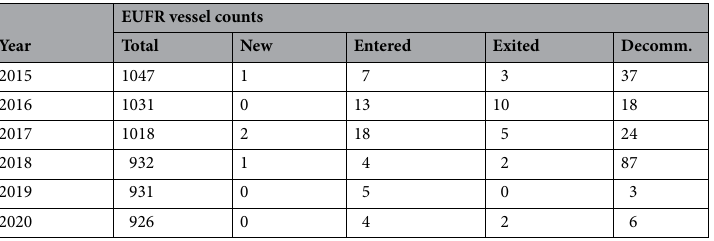
Table 2. Annual statistics of EU vessels registered to Adriatic ports according to the EU Fleet Register (EUFR): Total number of registered vessels; Newly constructed vessels; Vessels that moved their registration to an Adriatic port; Vessels that moved their registration outside the Adriatic; and Decommissioned